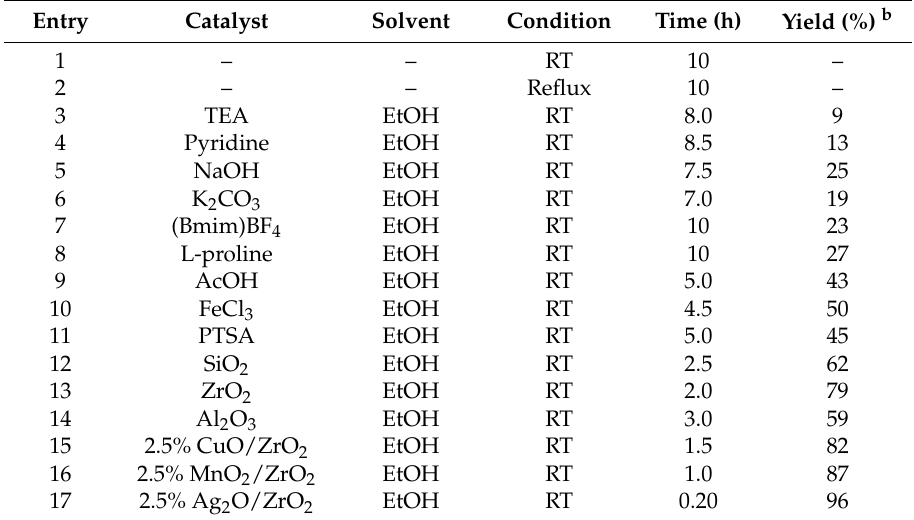
Table 1. Effect of catalysts on the synthesis of 4a a .